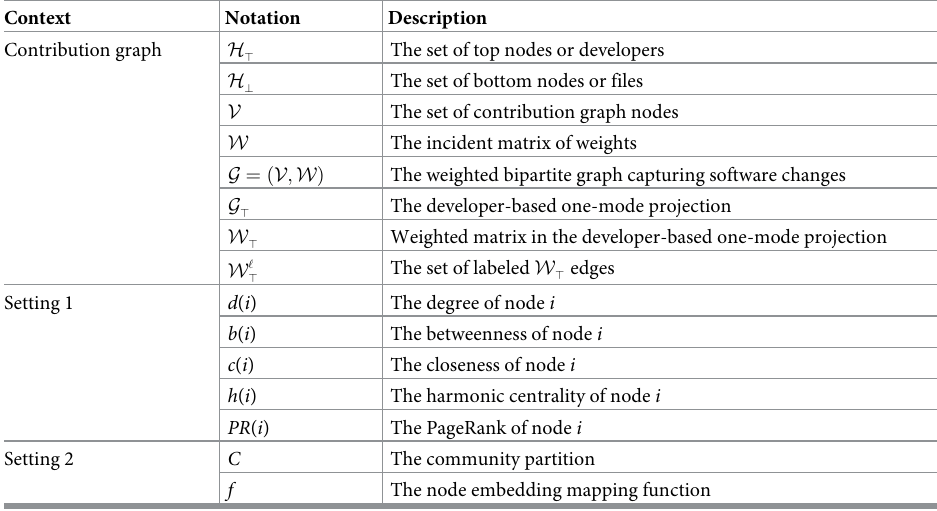
Table 2. Summary of notation